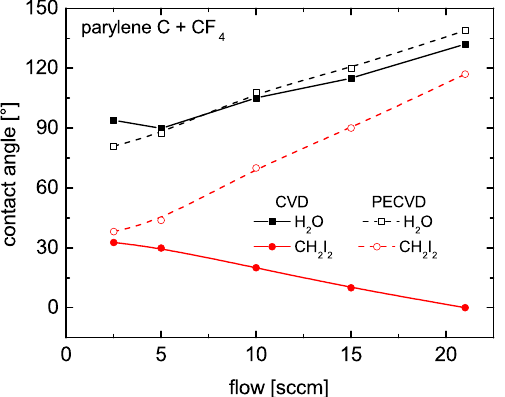
Figure 33. Doping of the atmosphere of mono- p -xylylene C (MPX-C) with CF 4 leads to increasing hydrophobic